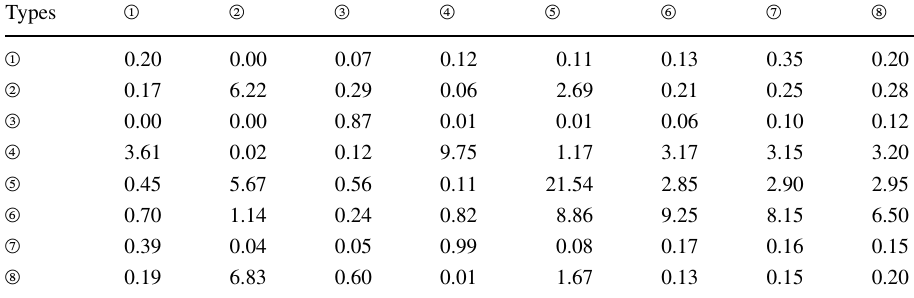
of wetland structure in the Dongping Lake from 1980 to 2000 (km 2 )